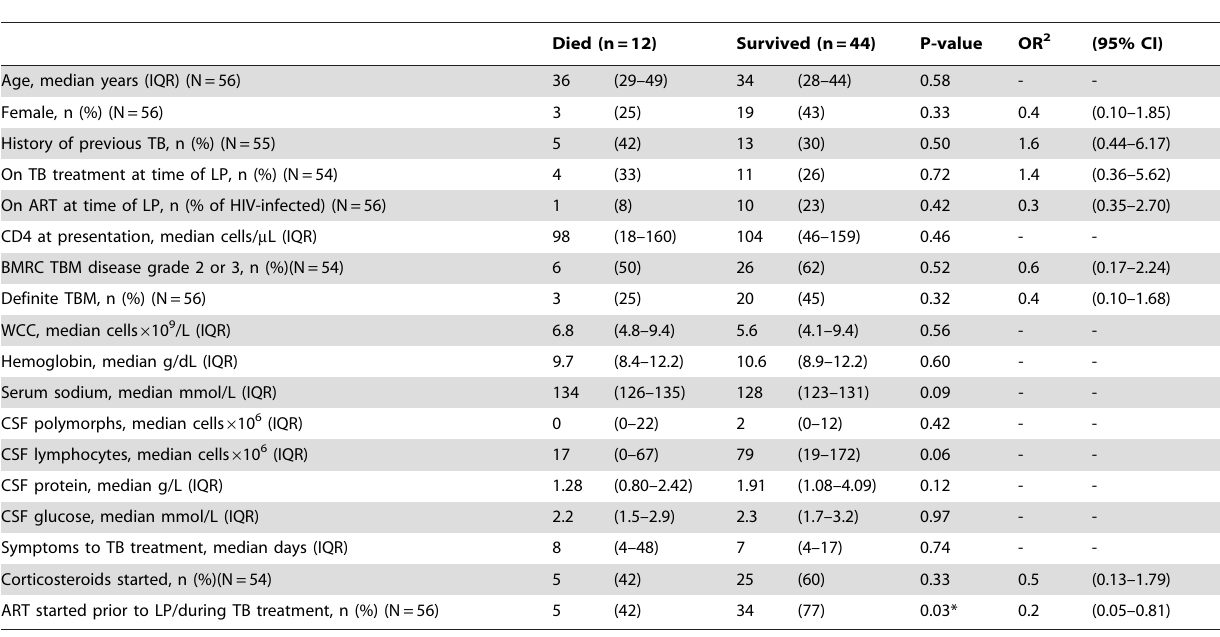
Table 6. Univariate analysis of variables associated with six-month mortality in HIV infected patients with definite, probable and possible tuberculous meningitis (n=56).